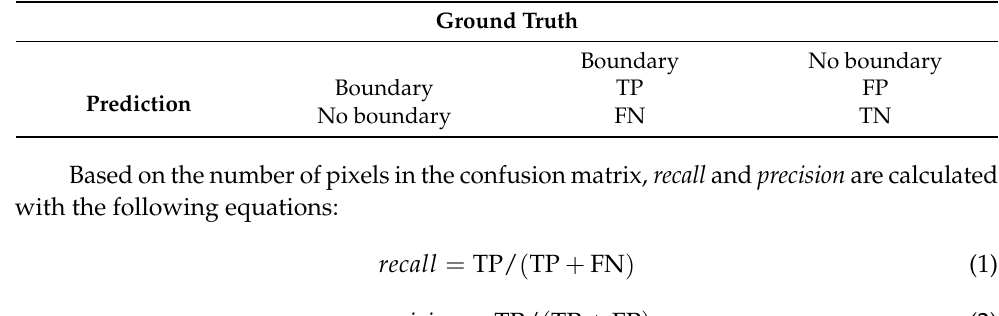
Table 2. Confusion matrix.